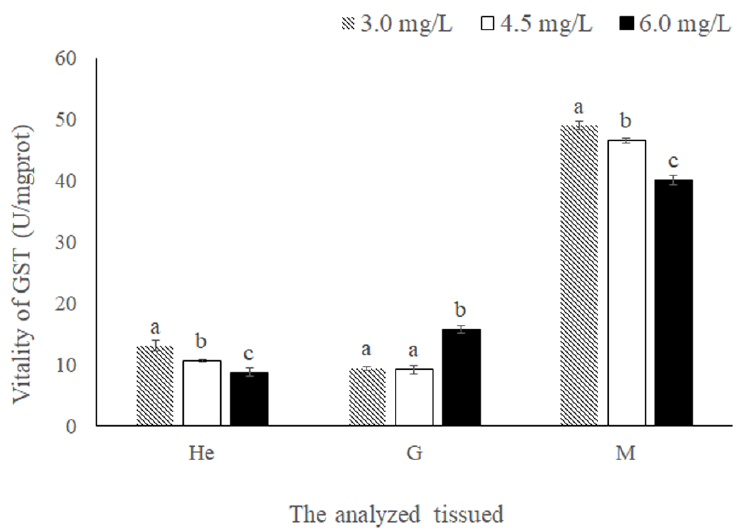
Figure 8. Enzyme activity of GSTs in the hepatopancreas (He), gill (G) and muscle (M) of M. nipponense in response to chronic hypoxia stress experiment. Data indicated with different letters are significantly different ( p < 0.05) between treatment and control groups. Values are means ± SE for triplicate samples.